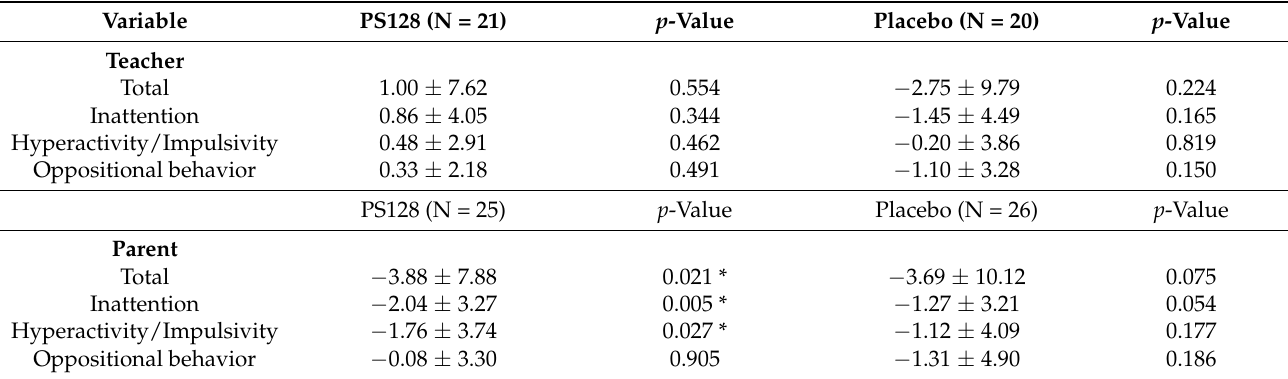
Table 4. Analysis of SNAP-IV teacher and parent questionnaires between 2 months and baseline.